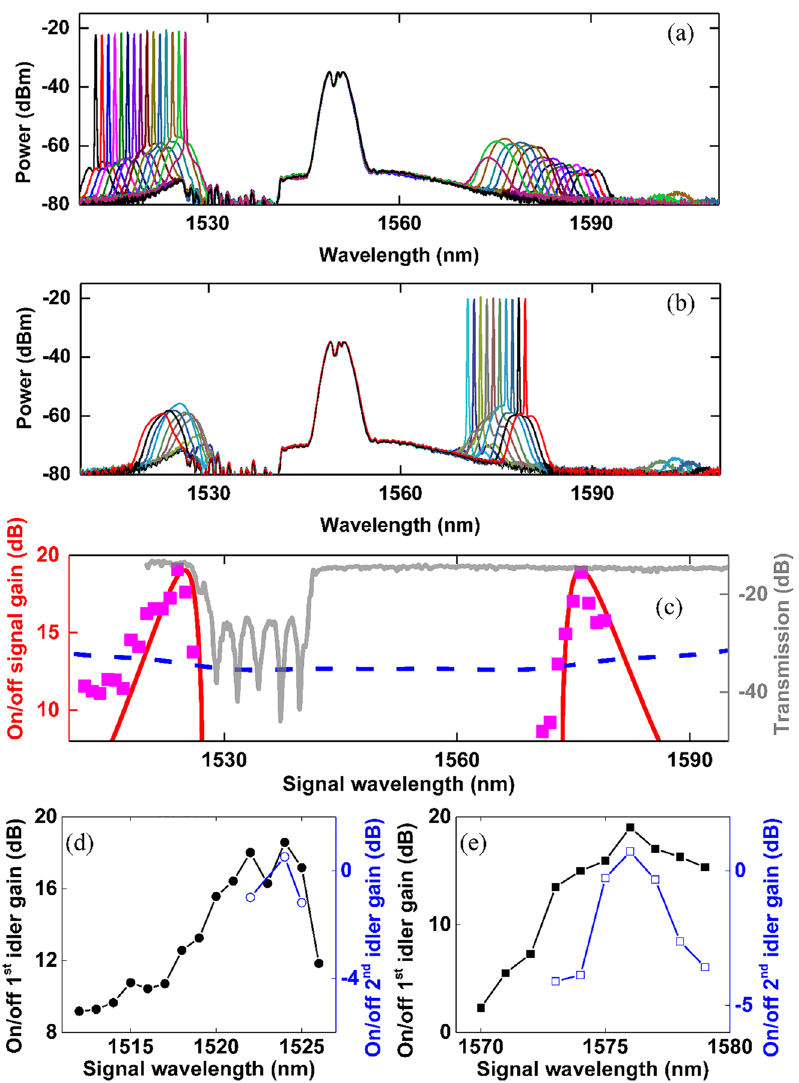
Figure 4: Experimentally measured FWM spectra for the optical parametric Bragg amplifier at the signal wavelength of (a) 1512 – 1526 nm and (b) 1570 – 1579 nm. (c) On/off signal gains (pink dots) are compared with theoretical curves in the CMBGs(redline)andWG(bluedashed).The grating transmission is presented as the grayline. 1st/2nd idler gains corresponding to the FWM spectra in (a) and (b) are shown in (d) and (e),